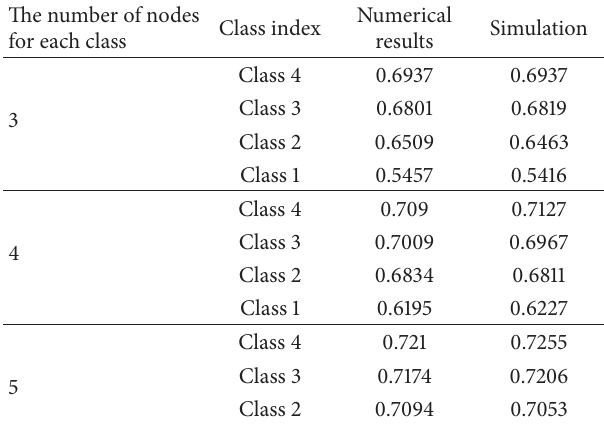
Table 3: Comparisons between numerical and simulation results on jitter (unit: sec).